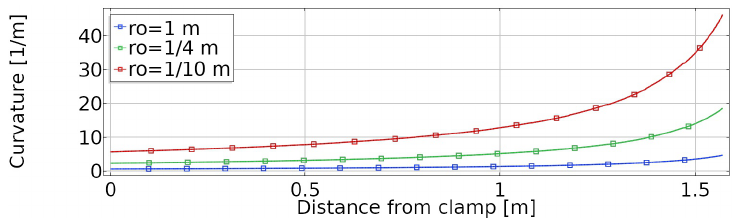
Figure 8: Curvature versus Distance from clamp for three different values of the parameter r o . The numerical solutions (markers) equal the explicit solution (solid line) given by (58).